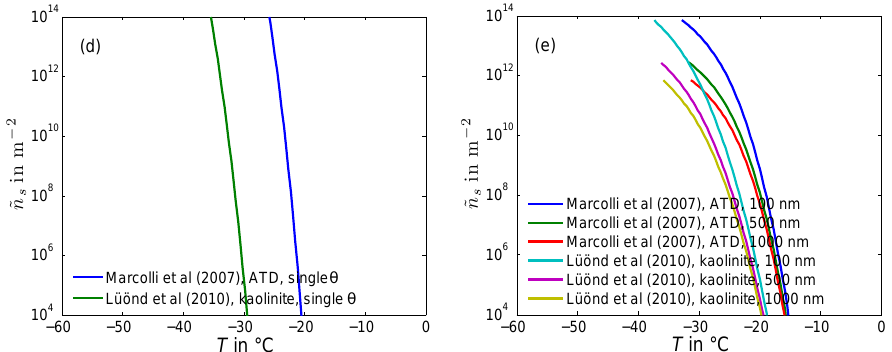
Fig. 18. (d) Apparent ˜ n s from CNT (as formulated by Zobrist et al. (2007)) with single contact angles, fitted by Marcolli et al. (2007) and L¨u¨ond et al. (2010). (e) Apparent ˜ n s from CNT with a distribution of contact angles, with parameters fitted by Marcolli et al. (2007) and L¨u¨ond et al. (2010), for different particle